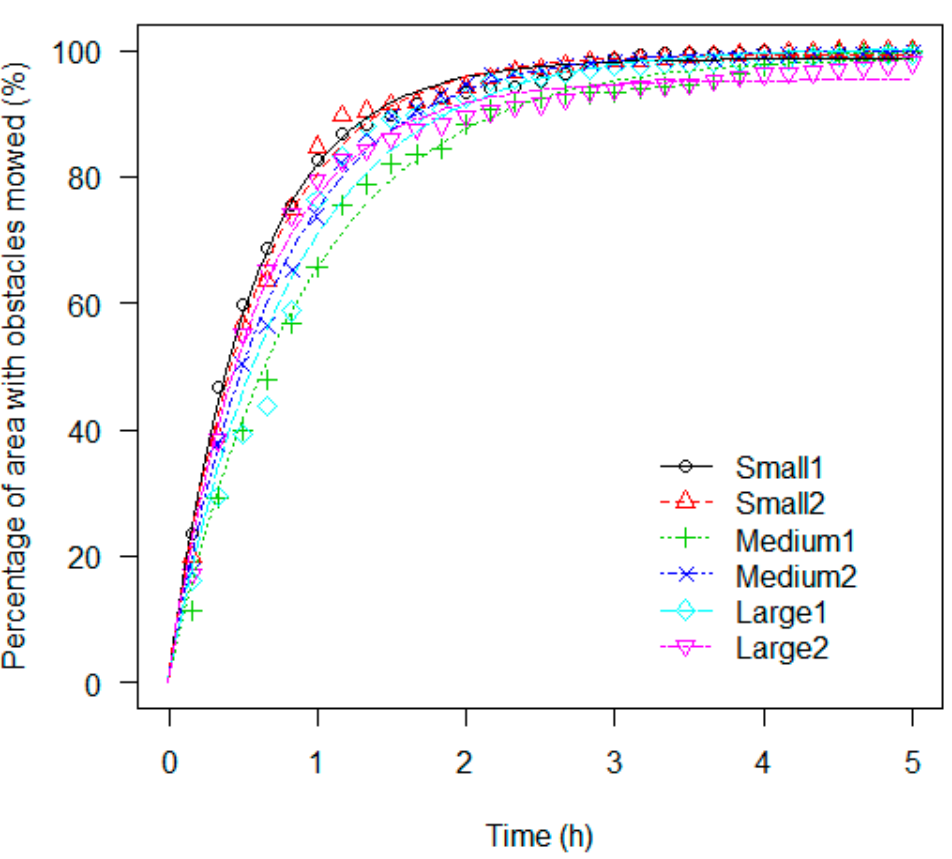
Figure 4. Fitted asymptotic regression curves with average points of the percentage of area with obstacles mown as a function of time (h) and autonomous mower type on Site A.